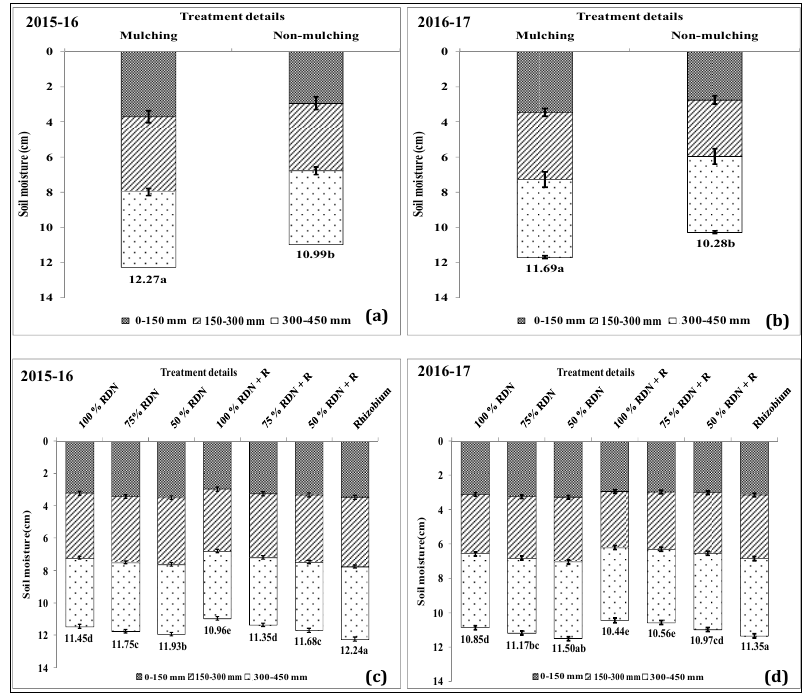
Figure 5. Effect of mulch ( a , b )and nutrient dose ( c , d ) on root zone moisture storage (cm) at the pegging stage of peanut (data from 2015–2016 and 2016–2017 crop seasons, respectively); within treatments numbers followed by different letters indicate significant differences at p ≤ 0.05 (otherwise statistically at par); error bars represent the least significant difference value. The soil moisture distribution and the root zone moisture storage during peanut pod formation are illustrated in Figures 6 and 7. The treatments grown under mulch had higher soil moisture contents, particularly at 0–150 mm depth. A similar trend in soil moisture storage was observed by